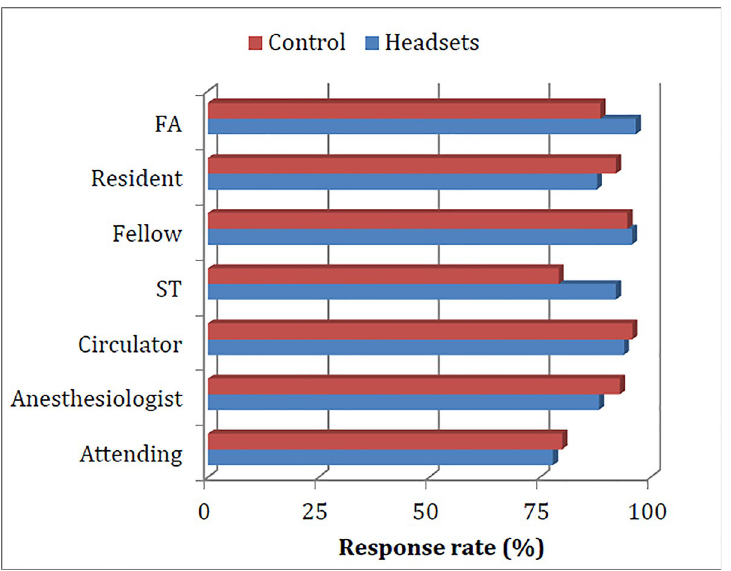
Fig 2. Response rate of team members, stratified by role. Abbreviations: FA, first assistant; ST, surgical technician.